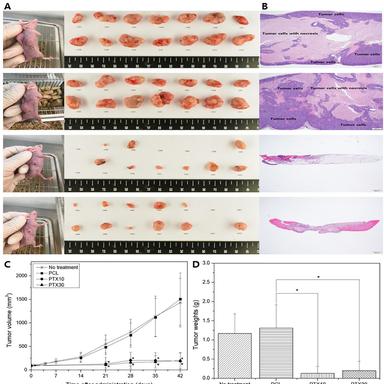
Representative pictures of (A) changes in subcutaneous tumor volume before sacrifice and tumor sizes after sacrifice and (B) histological images of H&E staining for each group of nude mice. Changes in (C) subcutaneous tumor volume and (D) tumor weight in nude mice at various time points PTX-containing groups inhibited tumor cell proliferation.(\p < .01 compared with the PCL group).